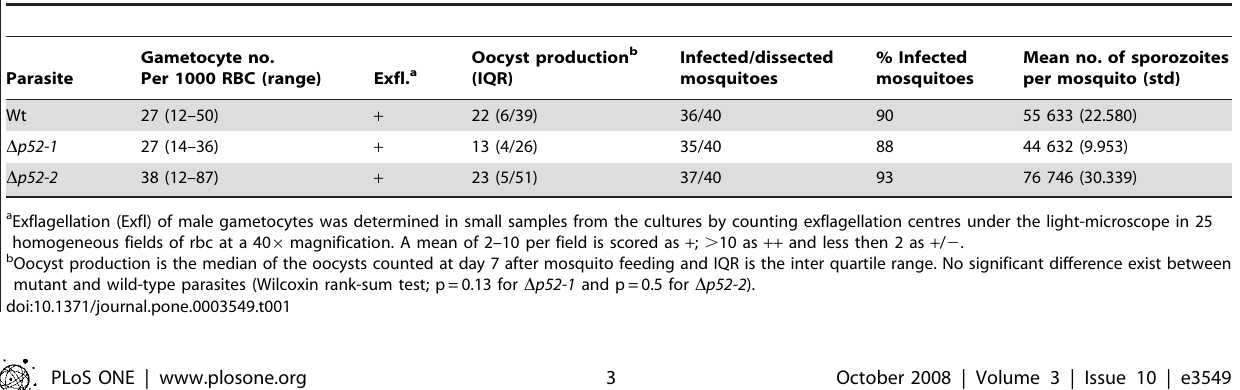
Table 1. Gametocyte, oocyst and sporozoite development of D p52 parasites.